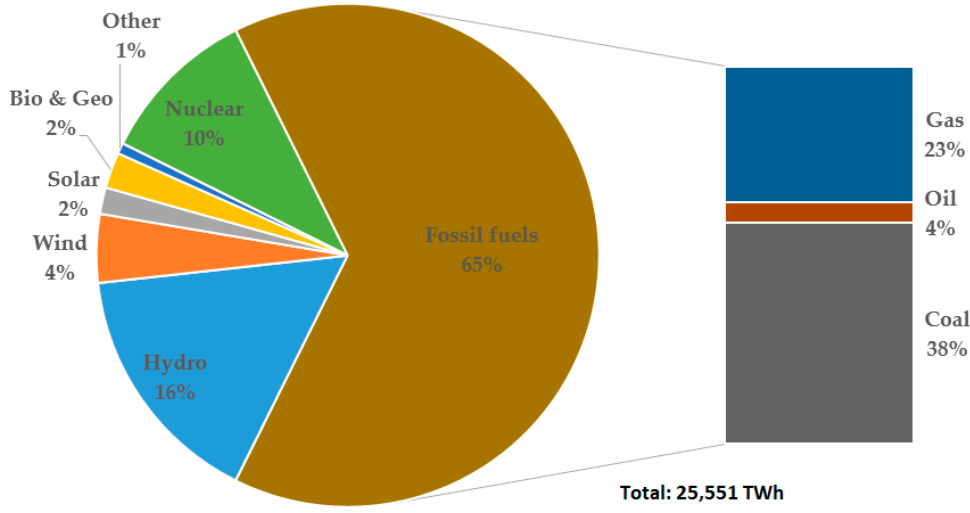
Figure 1. Electricity Generation Mix 2017 (Data from [2]).